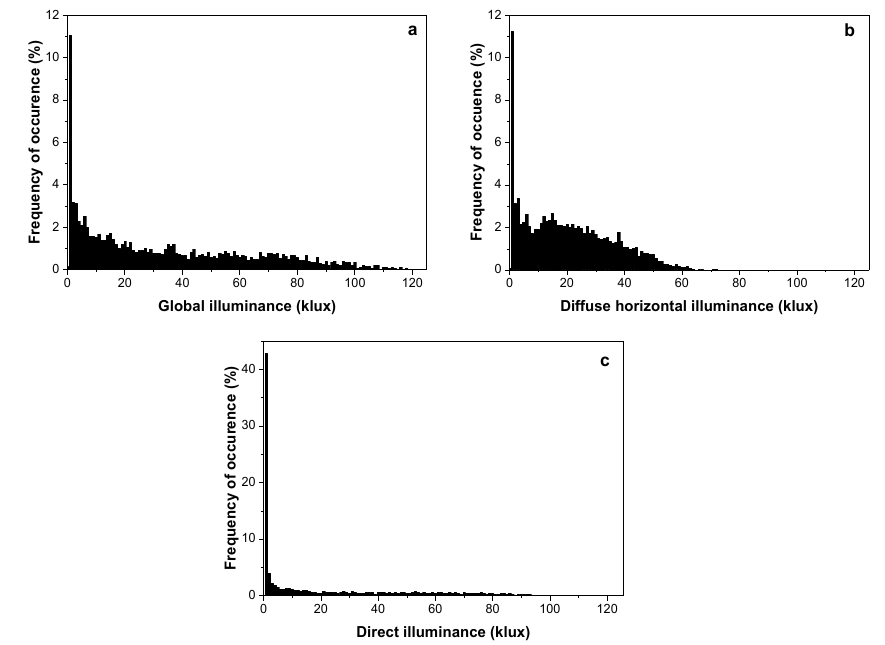
Figure 6. Frequency of occurrence of ( a ) global-, ( b ) diffuse- and ( c ) direct illuminance .